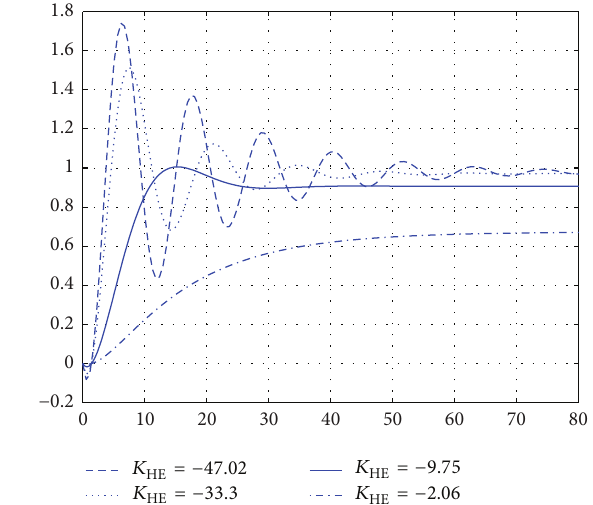
Figure 6: Step response of the closed-loop system with unit gain.